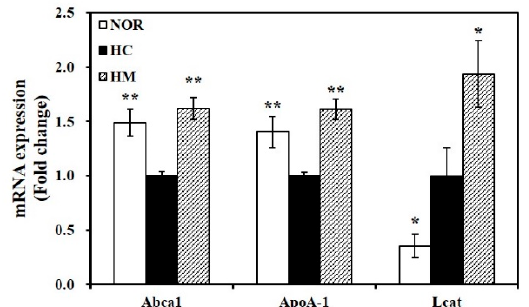
Figure 3. Effect of high hydrostatic pressure mulberry fruit extract on hepatic mRNA levels involved in HDL formation. ATP-binding cassette, subfamily A member 1 (Abca1), apolipoprotein A-1 (ApoA-1), and lecithin cholesterol acyltransferase (Lcat) mRNA levels were measured by RT-qPCR and normalized to β -actin. Data were expressed as fold change compared to the HC and are expressed as mean ± SEM ( n = 6). * p < 0.05; ** p < 0.01 compared to the HC diet. NOR, normal diet; HC, high cholesterol/cholic acid diet containing 1% cholesterol and 0.5% cholic acid; and HM, HC + 0.4% high hydrostatic pressure mulberry fruit extract.